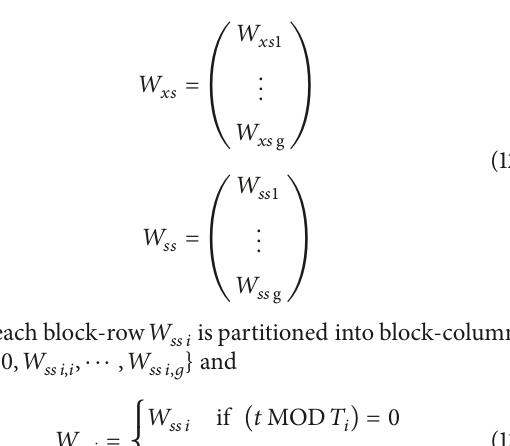
Figure 3, such a memory block consists of a cell, an input